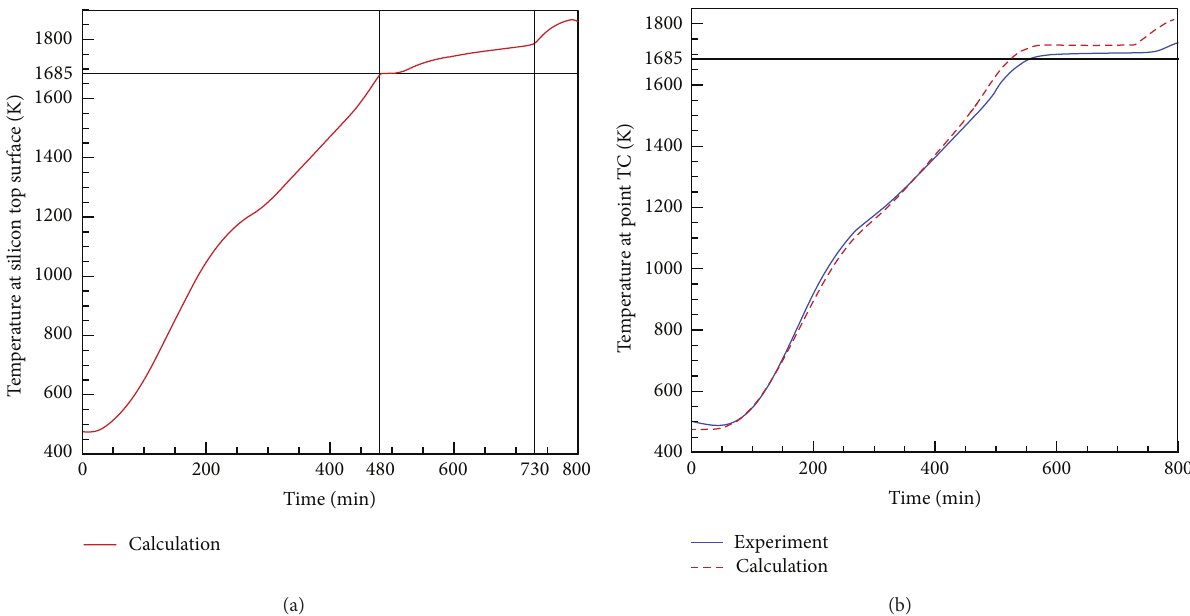
Figure 2: Temperature evolution at (a) silicon top surface and (b) point TC in the conventional DS furnace for a power distribution ratio of